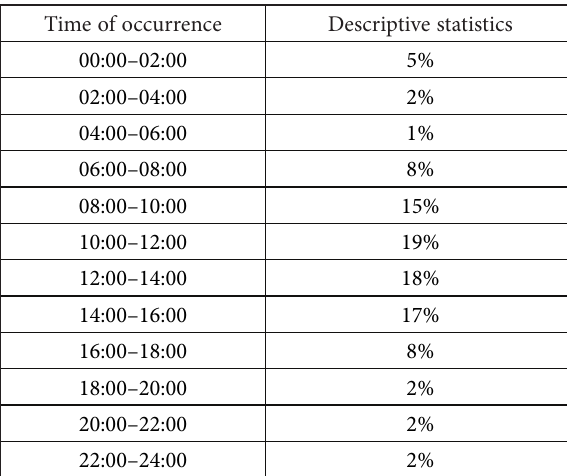
Table 5. Time of environmental